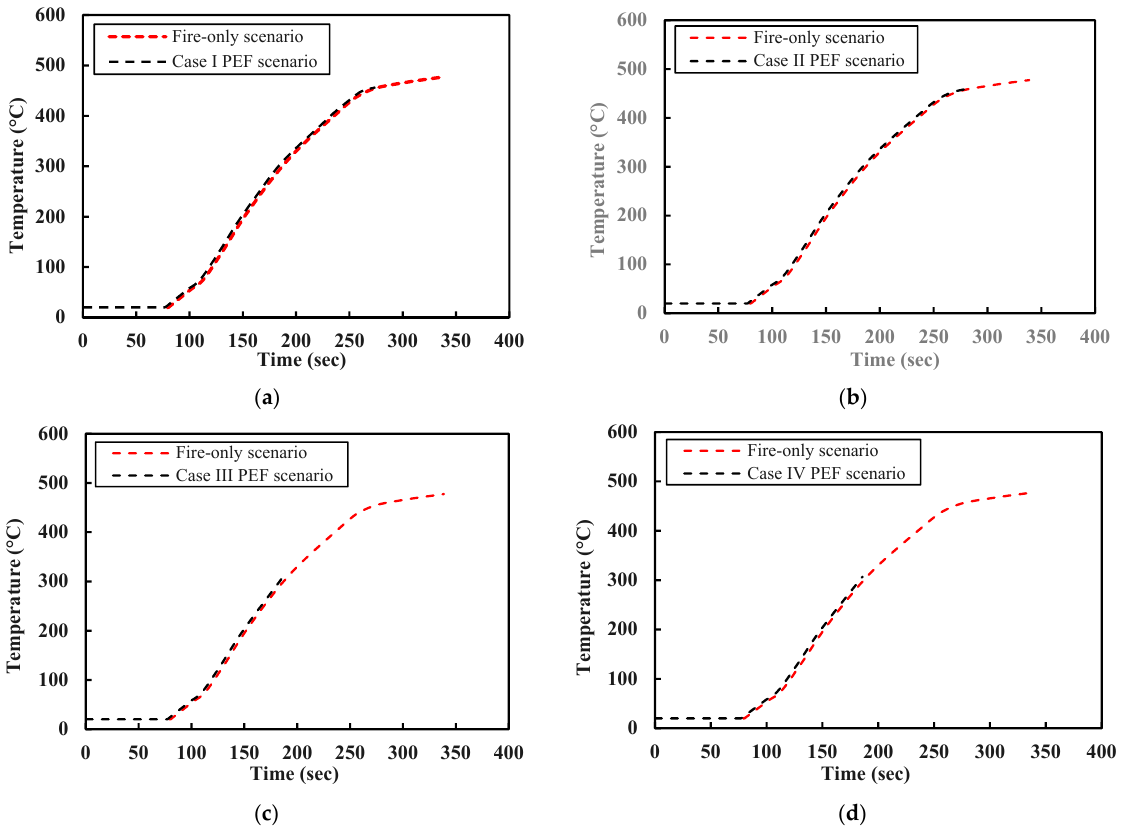
Figure 20. Comparison of the fire-only analysis versus the PEF analysis for the time -temperature response including ( a ) case I, ( b ) case II, ( c ) case III and ( d ) case IV. Table 2. Results comparison for all analysed circumstances.